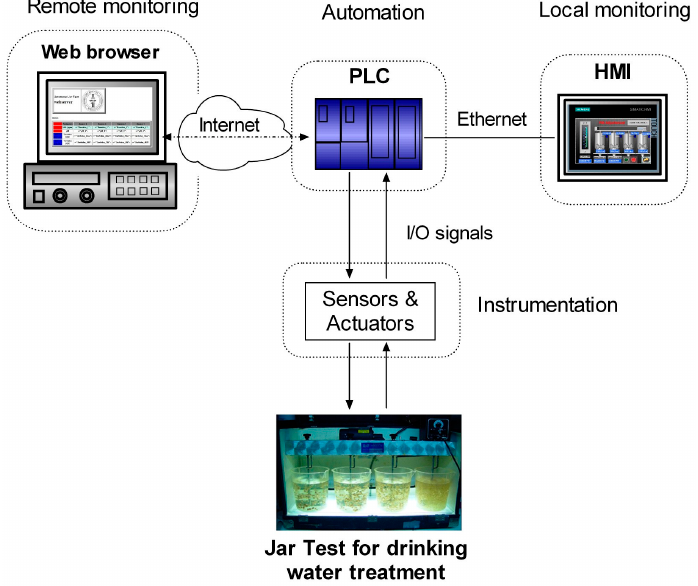
Figure 2. Block diagram of the developed system to automate and monitor the JT.